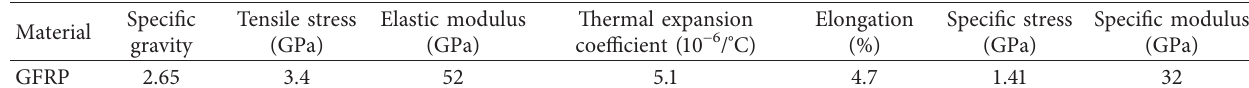
Table 2: Properties of GFRP.